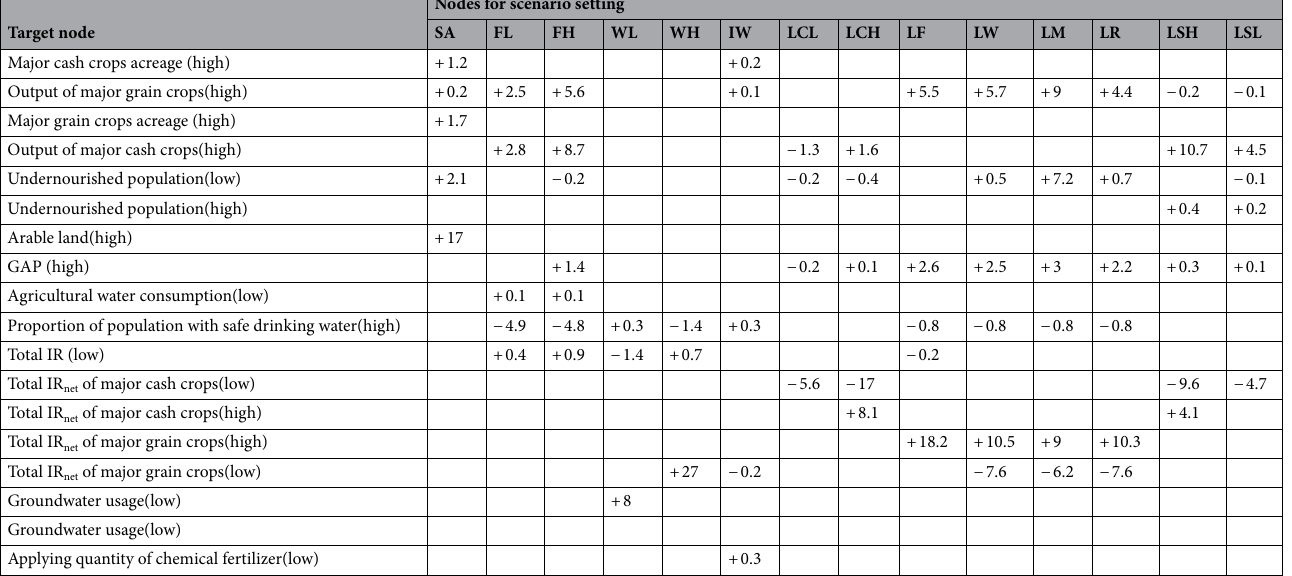
Table 1. Responses of the target variables to the scenario variables under different scenarios. SA saline-alkali land area (low), FL quantity of chemical fertilizer (low), FH quantity of chemical fertilizer (high), WL